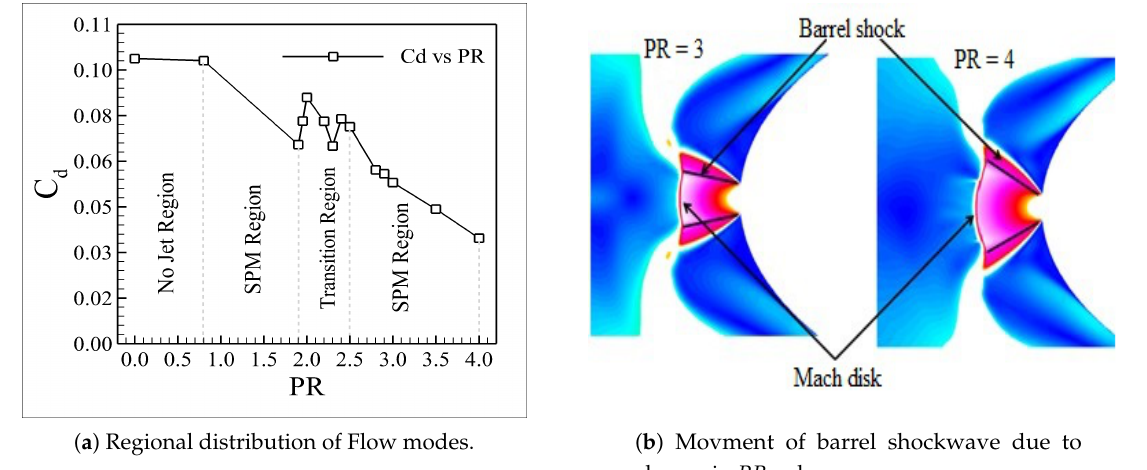
Figure 11. Under-expansion of opposing jet at different pressure ratio and its regional